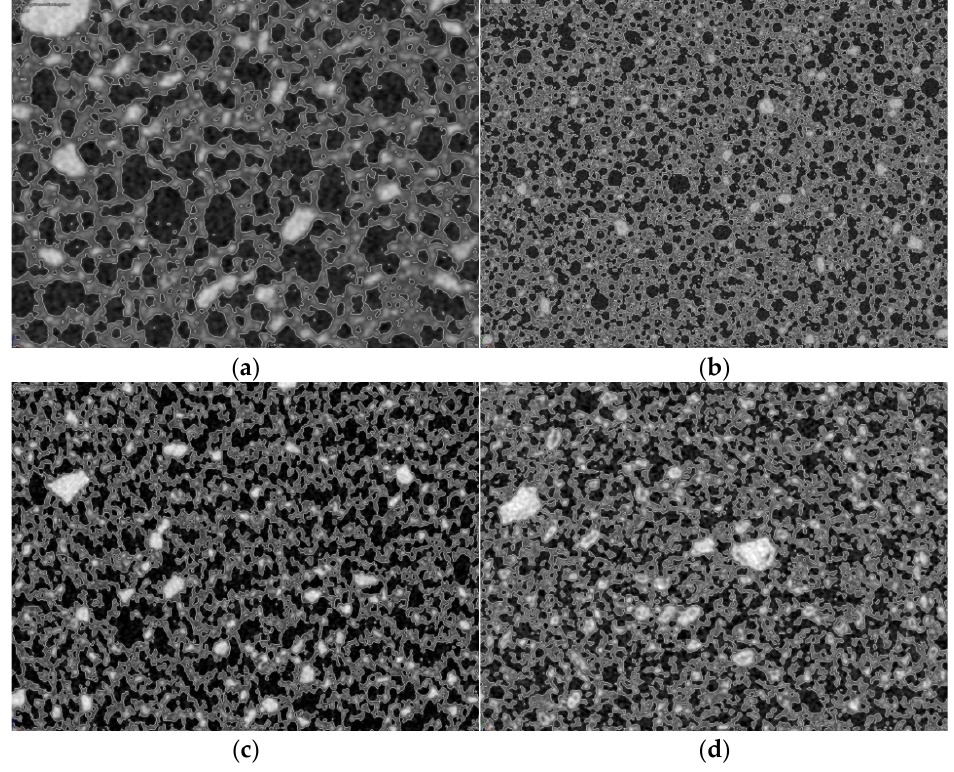
Figure 11. Effect of foaming components and heat treatment conditions on the pore structure of ( a ) S-4.5, ( b ) S-4.5-0.1, ( c ) S-4.5-0.1 treated with method No. 5 and ( d ) S-4.5-0.1 treated with method No. 5 after firing.